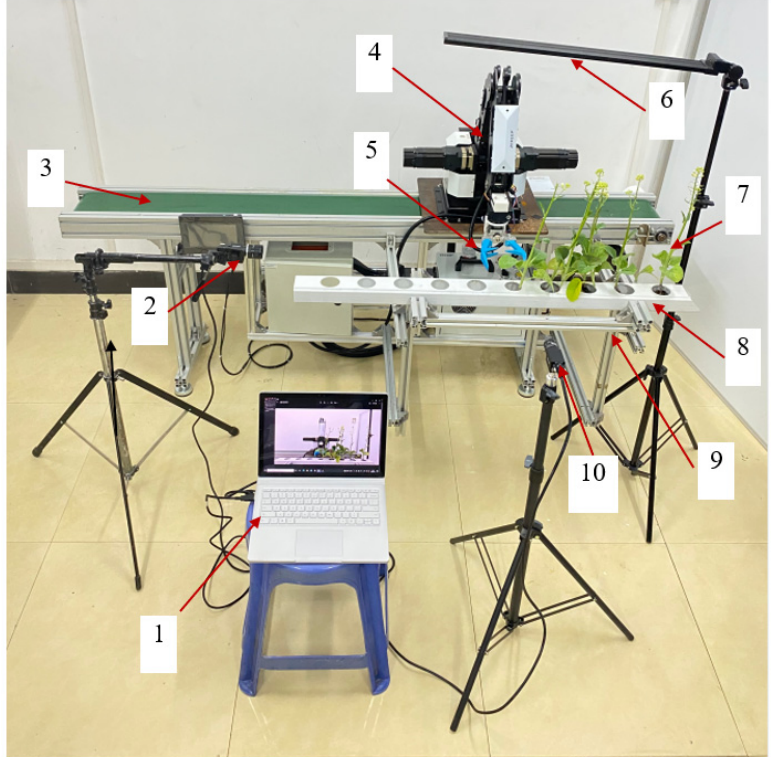
Figure 11. Grasping test platform. 1. Laptop; 2. no.1 high-speed camera; 3. conveyor belt; 4. robotic arm; 5. grabbing mechanism; 6. fill light; 7. hydroponic Chinese kale; 8. cultivation pipeline; 9. brackets for cultivation pipeline; 10. no.2 high-speed camera.